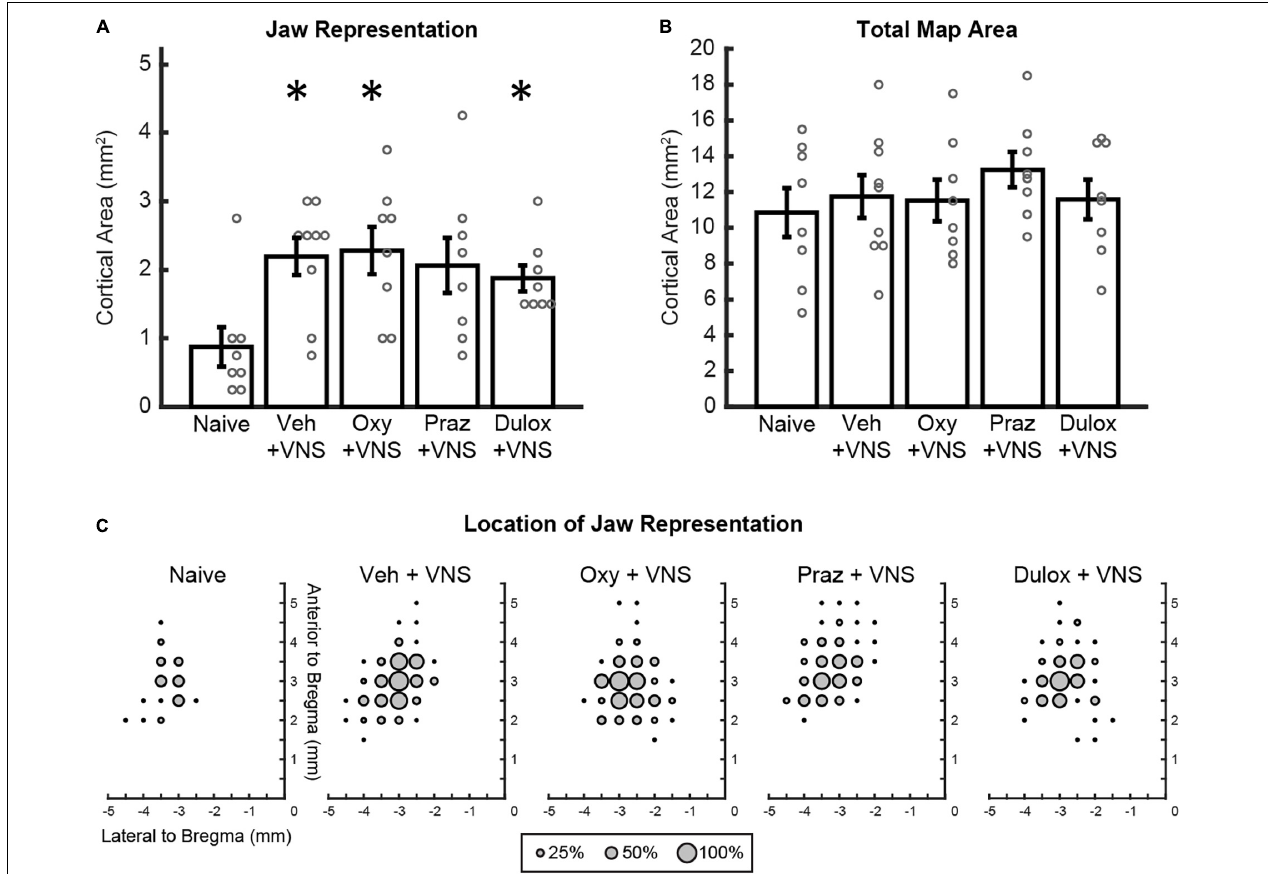
FIGURE 2 | Clinically relevant doses of oxybutynin, prazosin, and duloxetine do not interfere with VNS-mediated plasticity. (A) VNS and daily injections of oxybutynin, duloxetine, and saline significantly enhanced jaw representation compared to naïve subjects. Injections of oxybutynin, prazosin, and duloxetine did not significantly reduce jaw representation compared to saline in animals that received VNS paired with training. (B) No change in total motor cortex area was observed between groups. (C) Average plots of the location of jaw movements for all animals during ICMS. Bars represent mean ± SEM. “ ∗ ” indicates p < 0.0125 compared to